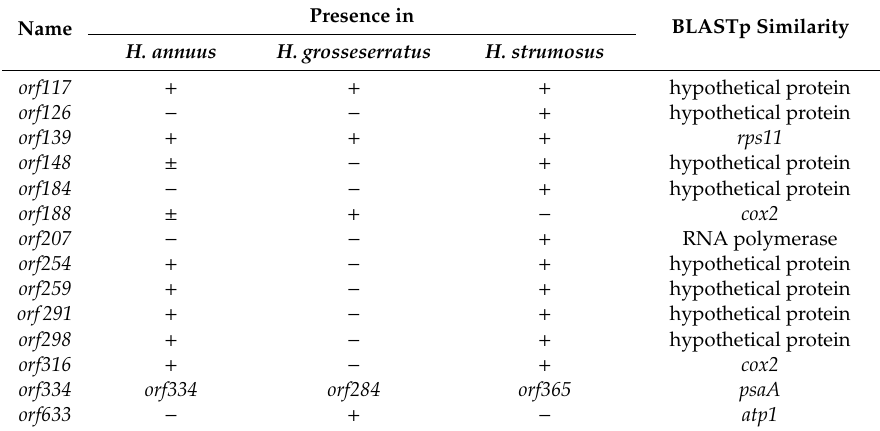
Table 2. ORFs annotated in H. grosseserratus and H. strumosus mitogenomes. The ORFs are named by their amino acid length. orf148 —present in H. annuus with PET2 CMS type, orf188 —similar ORF presented in H. annuus with ANN2 CMS